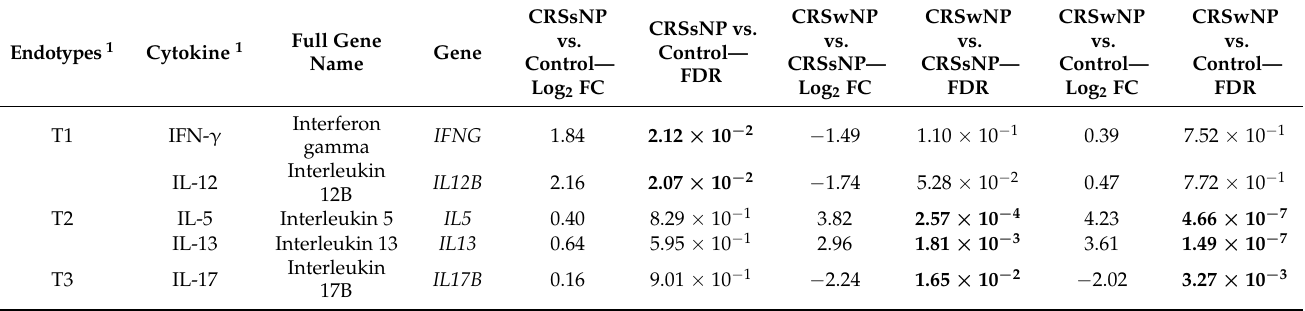
Table 3. Cytokine-related genes and their expression presented with their Log2 fold change values and false discovery rate (FDR), comparing CRSwNP/CRSsNP and controls. FDR values of 0.05 or less are outlined in